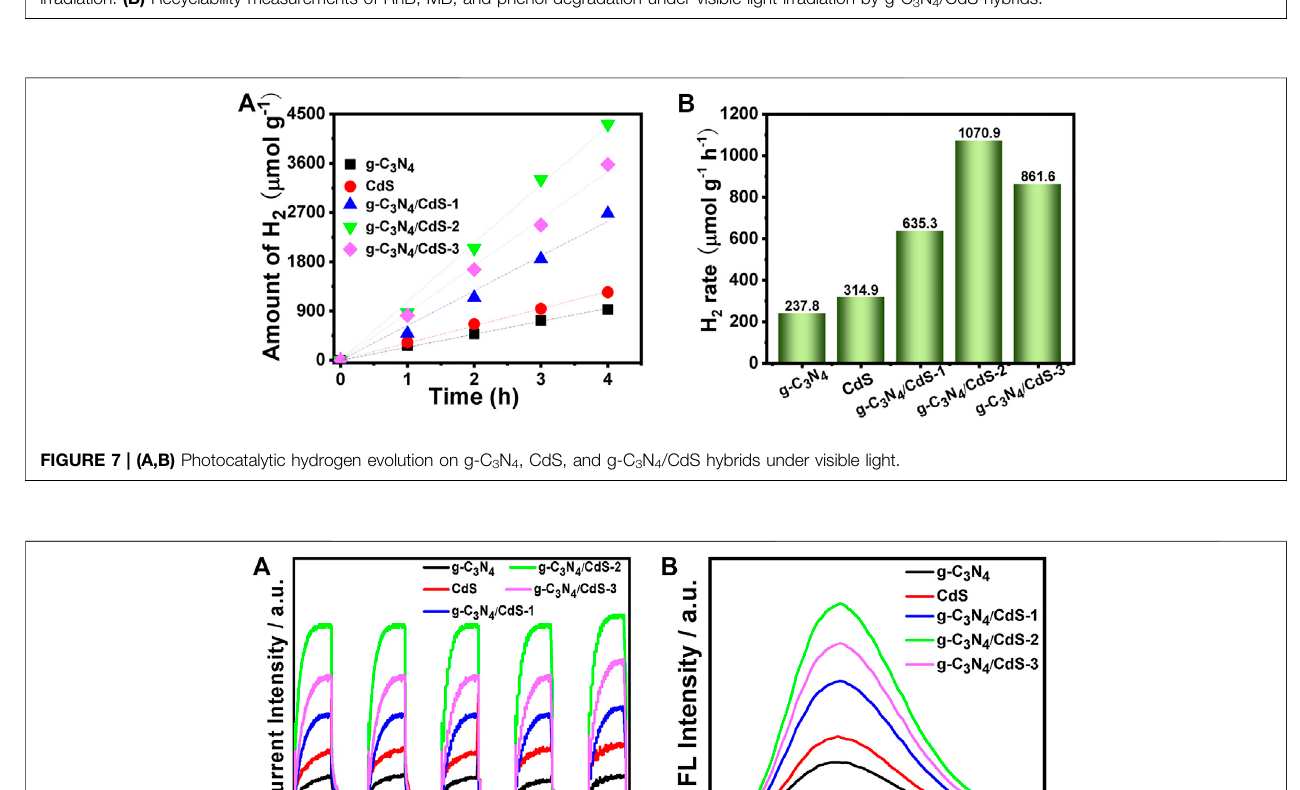
the target molecules. In the process of photocatalytic reaction, the can effectively degrade the organic pollutant molecules (Huo et al., photoexcited electrons may reduce H + into hydrogen. Meanwhile, 2012; Wu et al., 2018). The produced hydroxyl radicals can be the accumulated electrons on the surface of CdS can oxidize the measured by the fl uorescence method with terephthalic acid as the adsorbed dissolved O 2 to produce (cid:129) O 2 − and subsequently form probe reactant (Xiao et al., 2008; Yu et al., 2009; Wang et al., 2017b). − and (cid:129) OH) (cid:129) OH. The formation of powerful reactive species ( (cid:129) O The fl uorescence spectra of all samples are shown in Figure 8B , 2